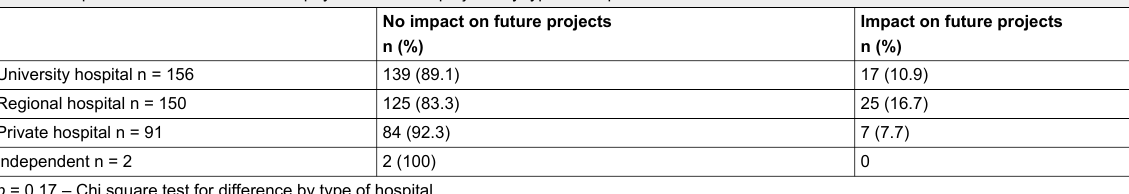
Table 5: Impact of licences restriction on physicians‘ future projects by type of